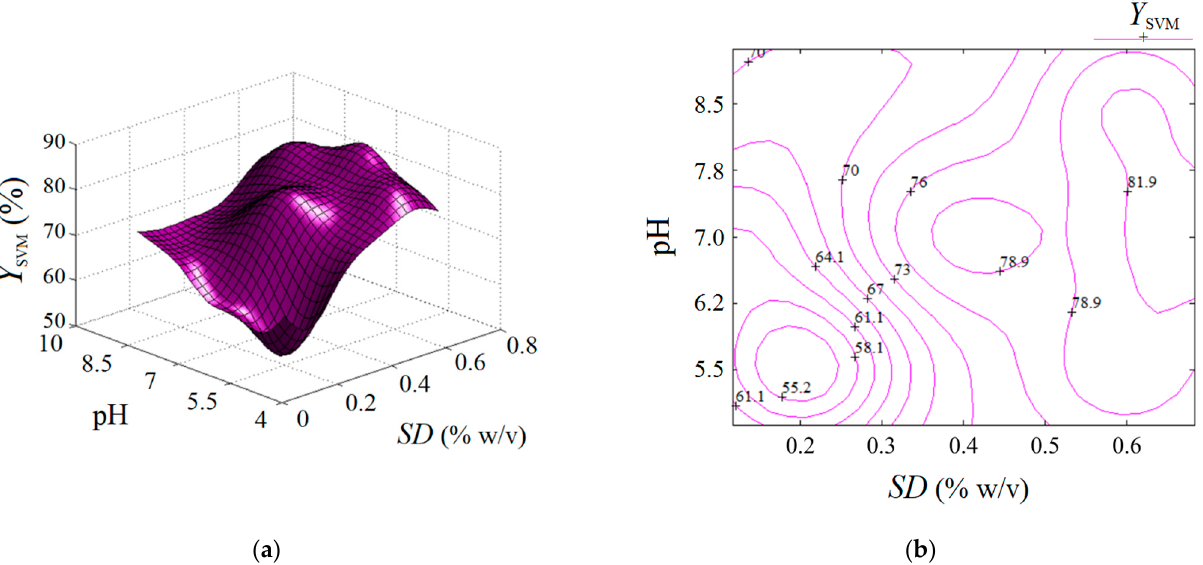
Figure 8. Predictions given by SVM model: ( a ) response surface plot (3D graph), and ( b ) contour-lines map (2D) showing the estimated response ( ˆ Y SVM ) depending on pH and SD (g/L)